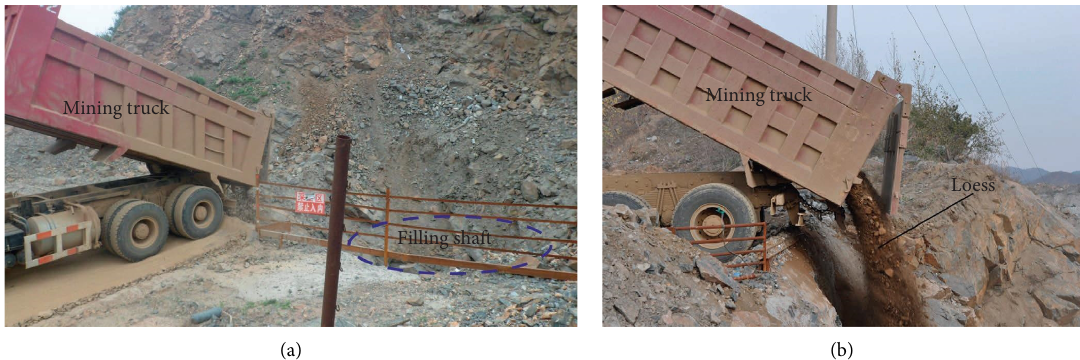
Figure 4: Te flling process by mining truck. (a) Waste rock flling. (b) Loess